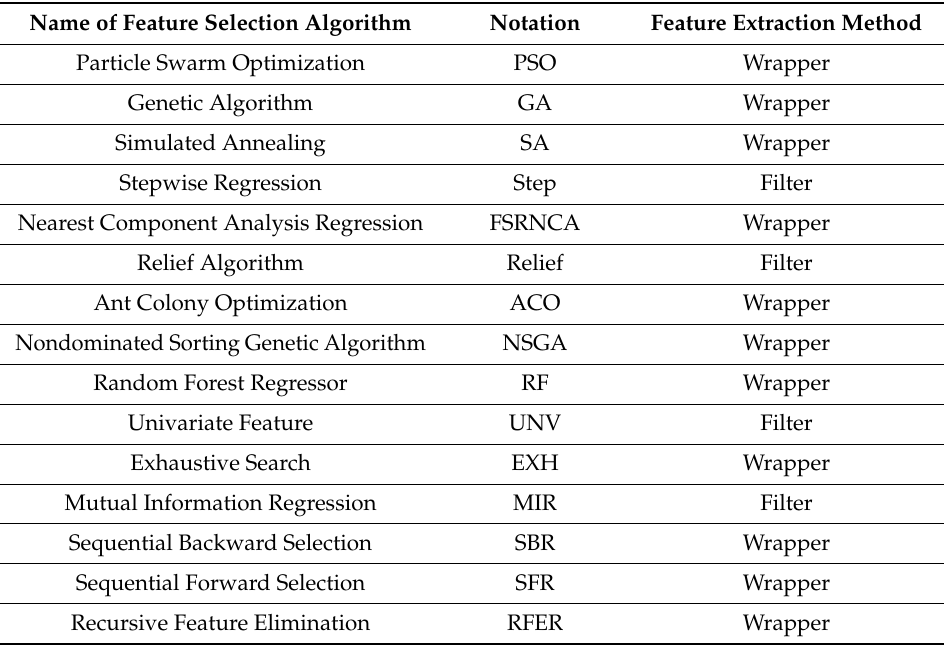
Table 2. ( a ) Description of the 15 feature selection algorithms applied to obtain the best predictors of GSR from a global pool of MODIS-derived variables used to predict long-term GSR in Australia’s solar cities; ( b ) List of MODIS-derived predictors screened at each solar city in Australia after applying the feature selection algorithm (Table 2a). All notations as per Tables 1 and 2a. ( a